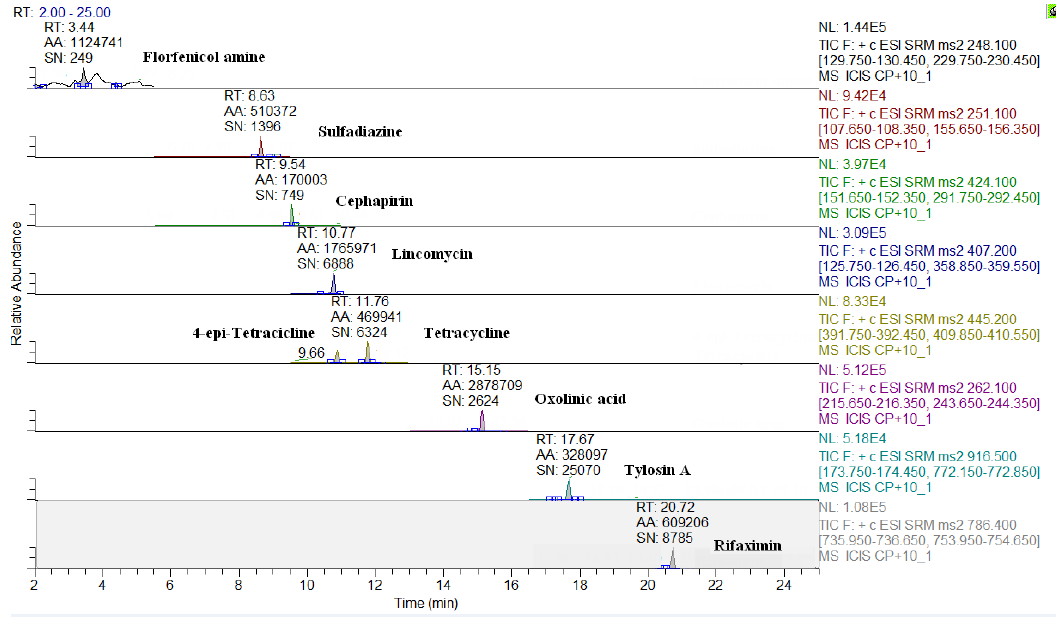
Figure 2. LC-QqQ chromatograms of a spiked bovine muscle (10 µg·kg −1 ).